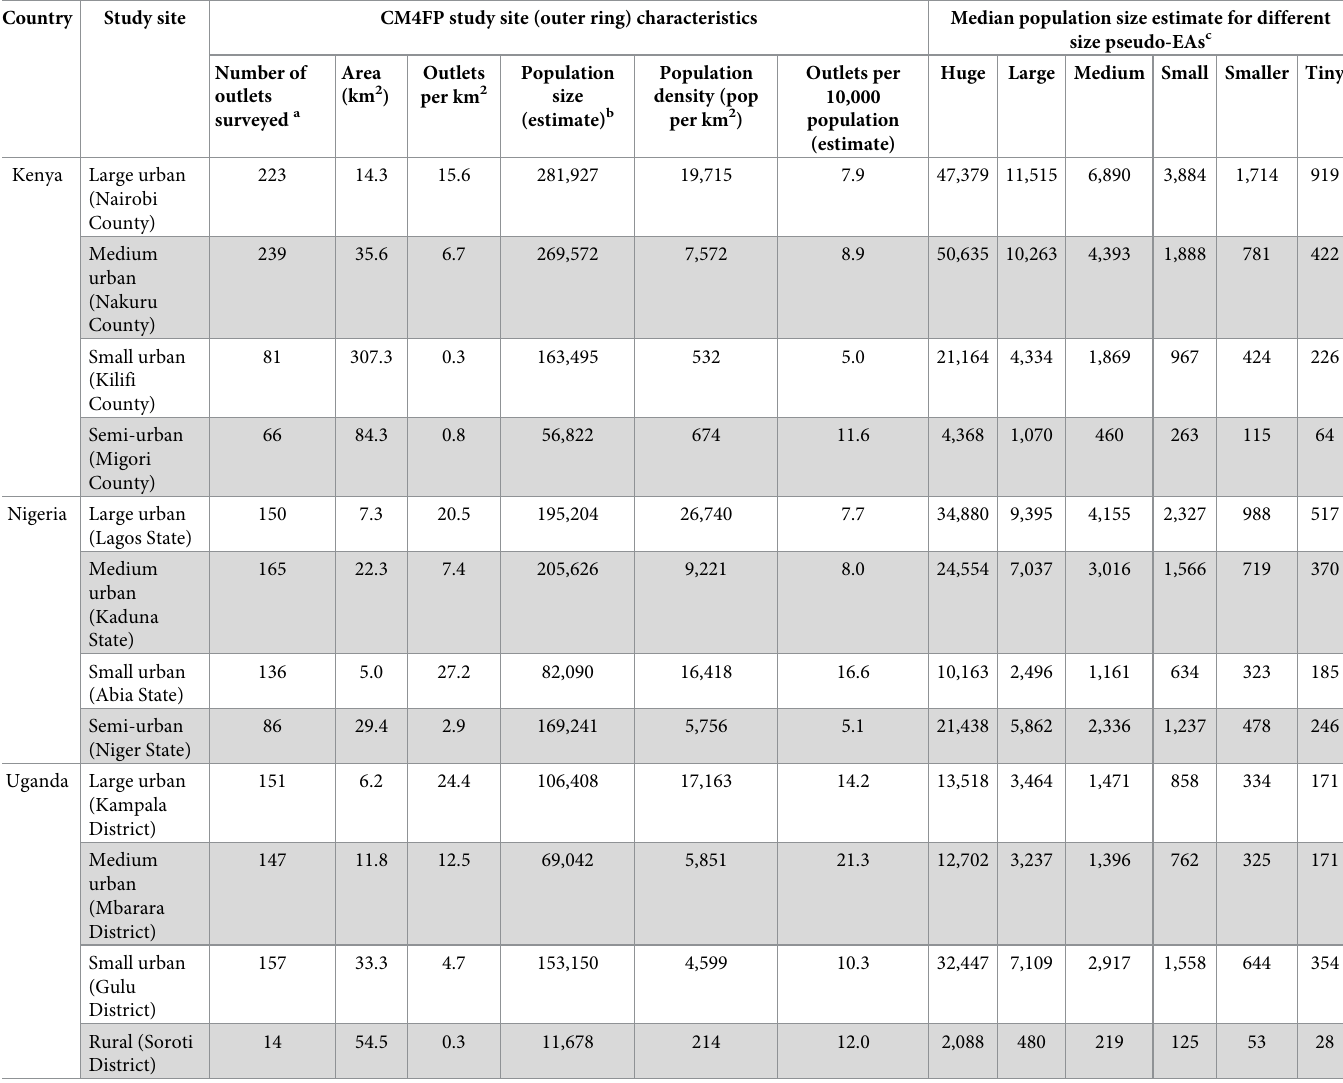
Table 1. Characteristics of CM4FP study sites and estimated population size of pseudo-EAs.